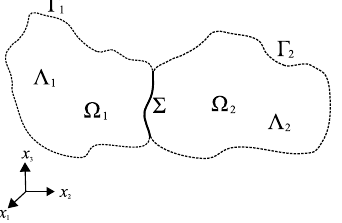
Fig. 2. in the domain Ω where Σ = ∂ Ω r \ Γ r , and Λ r = Ω r ∪ Γ r . x = [ x 1 ,x 2 ,x 3 ] is the position in